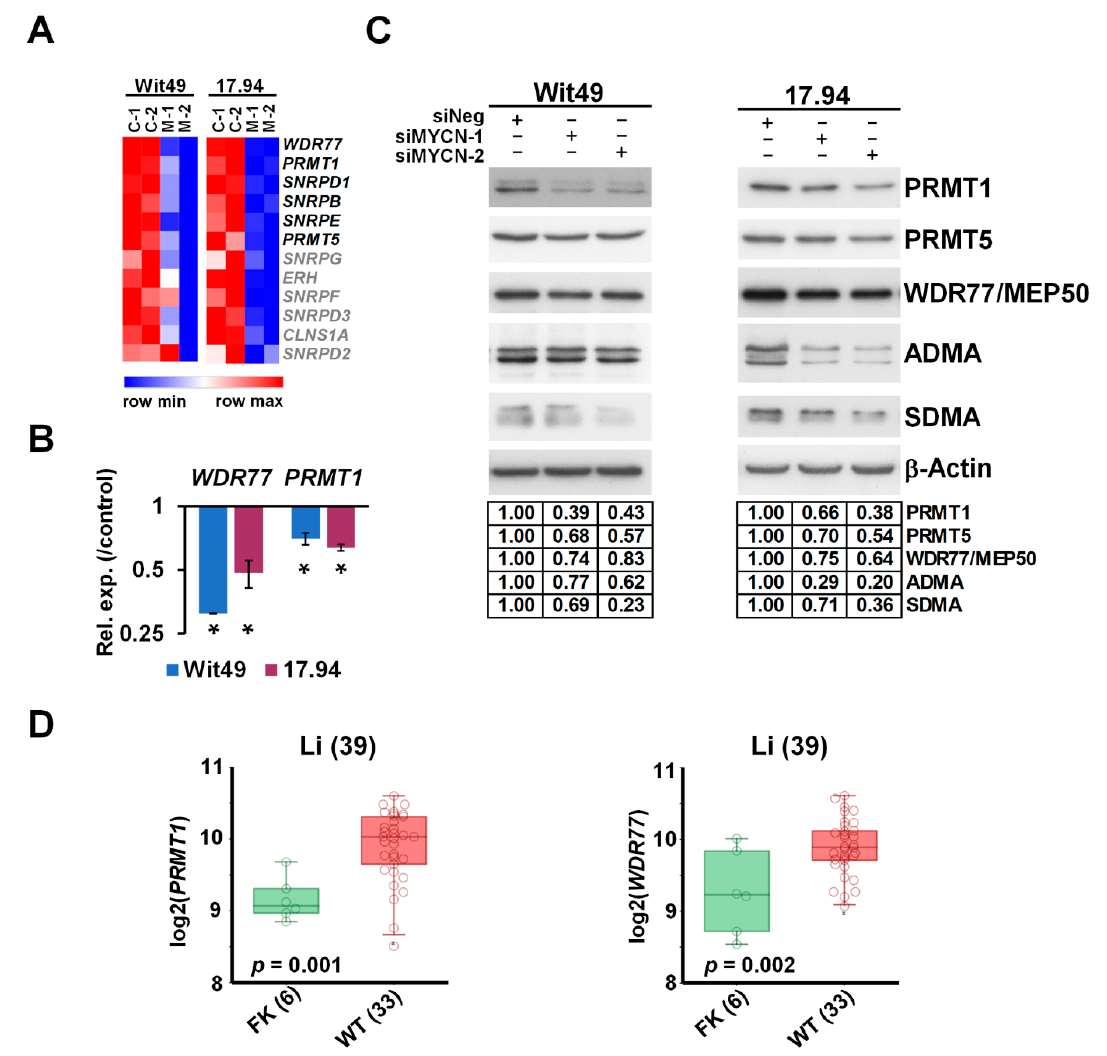
Figure 6. MYCN activates methylosome genes in WT. ( A ) Heatmap of genes encoding for methylosome components, showing expression in MYCN-depleted WT cells. Genes highlighted in black were identified in this study as significantly and substantially regulated by MYCN in two anaplastic WT cells. ( B ) Validation of select methylosome genes in WT cells by qPCR, 48 h after MYCN knockdown. Statistical significance was calculated based on biological replicates, and expression for one representative is shown (* p < 0.05). ( C ) Western blot of select methylosome components in WT cells 72 h after MYCN knockdown with two different siRNAs ( n = 3). Protein expression was calculated based on densitometry and normalised for the loading control on the same filter. Confirmation of MYCN depletion is shown in Figure 5D. ( D ) PRMT1 and WDR77 , encoding for MEP50, were shown to be expressed at significantly higher levels in WT than in the fetal kidney (GSE6120). Uncropped Western blots are available in Figure S5C.